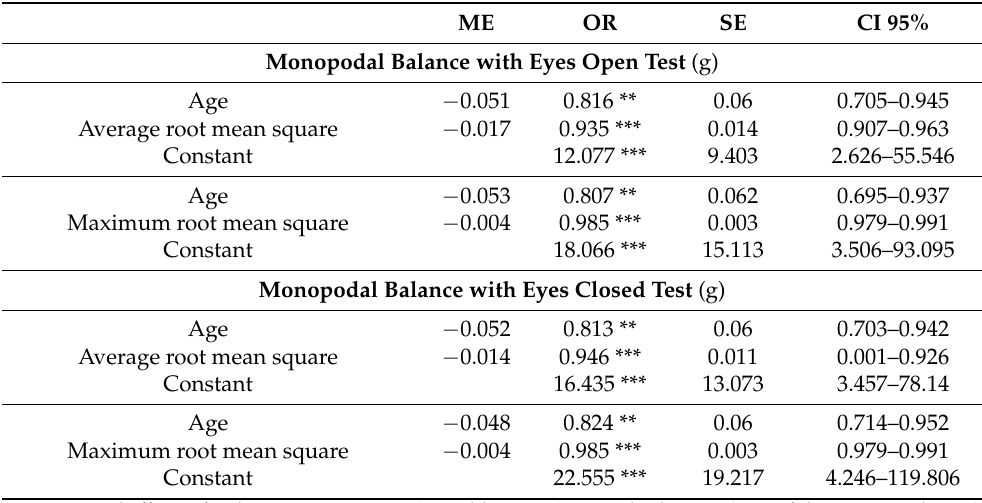
Table 4. Models of logistic regression for sex adjusted for postural control root mean square accelero- metric values and